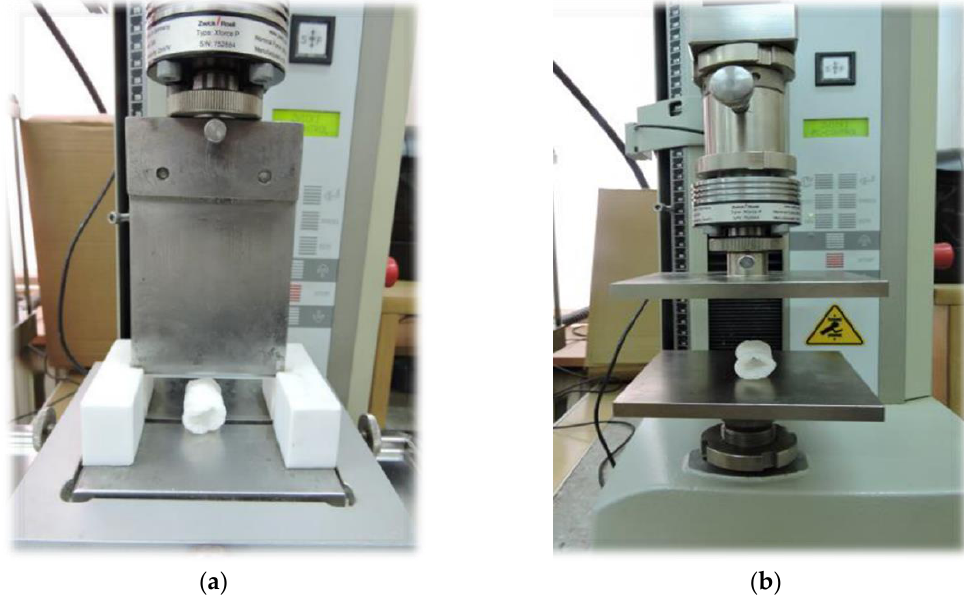
Figure 2. Zwick type BDO-FBO0.5TH equipped with: ( a ) Warner–Bratzler’s knife and ( b ) compression flat plates.